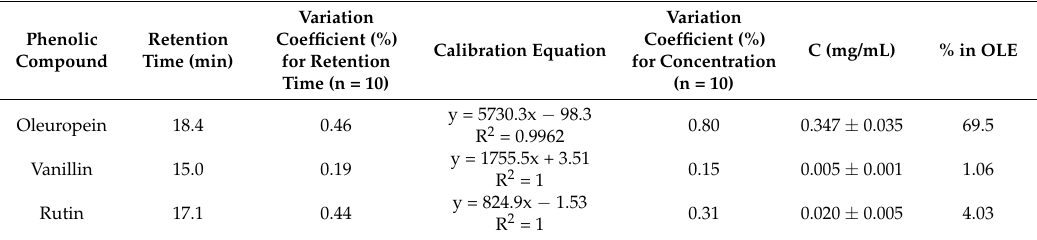
Table 3. Characterization of indicative batches of blank PLA nanoparticles (blank-NPs) and PLA nanoparticles loaded with oil leaves extract (OLE-loaded NPs): particle size, polydispersity index (Pdi), ζ -potential, encapsulation efficiency (EE).